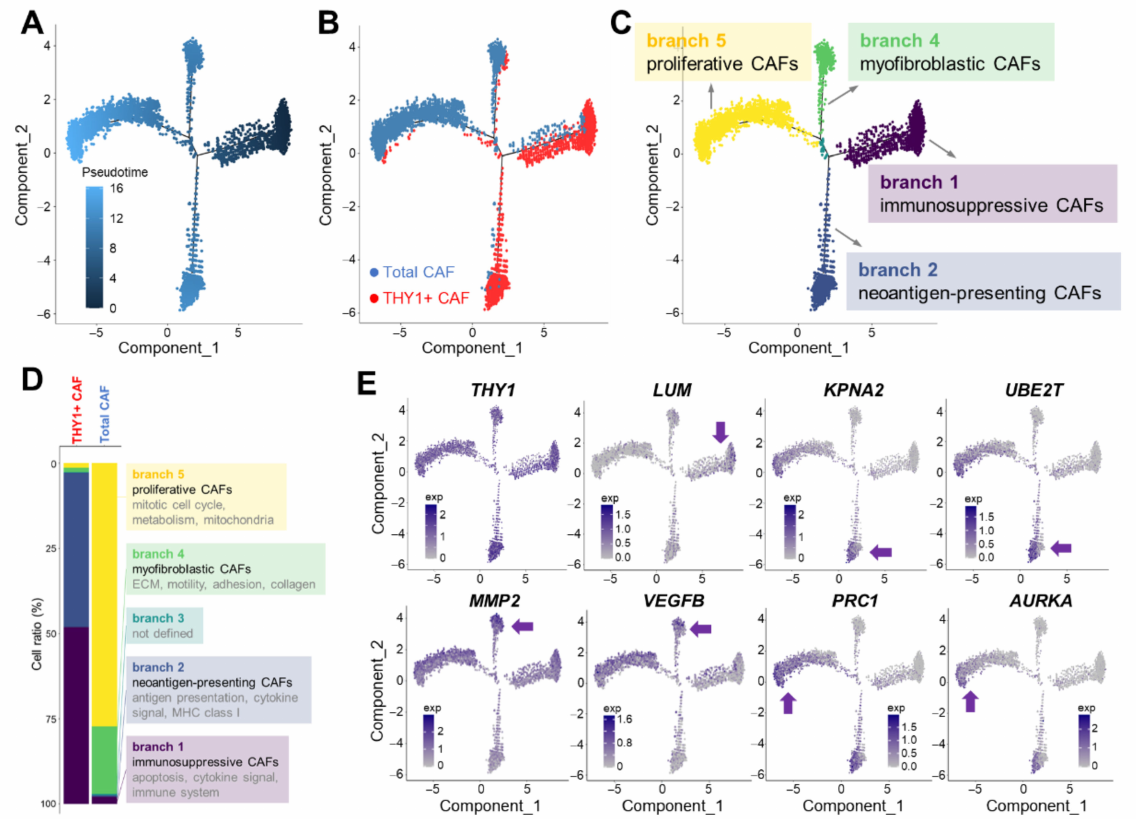
Figure 3. Cell trajectory analysis of CAF scRNA-seq data. ( A ) Cell trajectory analysis of both CAFs. Color intensity means pseudotime. ( B ) Cell trajectory mapping of total and THY1 + CAFs. ( C ) Five branches were identified through the cell trajectory analysis. Branch 1 represents immunosuppressive, Branch 2 represents neoantigen presenting, Branch 4 represents myofibroblastic, and Branch 5 represents proliferative CAFs. ( D ) GO analysis of branch-specific marker genes. Ratios (%) of each branch in total and THY1 + CAFs are shown in the bar chart. ( E ) Cell trajectory plots showing the expression patterns of THY1 and branch-specific markers. The branch corresponding to each marker is indicated by an